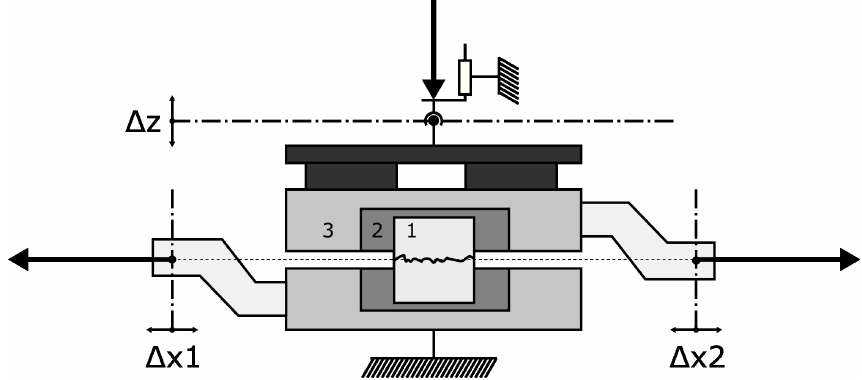
Figure 4. BCR3D. ( 1 : Sample; 2 : internal metallic boxes; 3 : external metallic boxes).